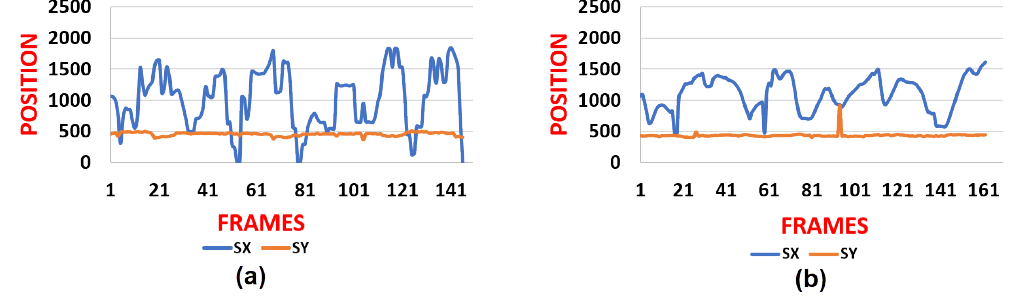
Figure 13. Change in viewpoint for variation 2 (pixels) ( a ) RC, ( b )